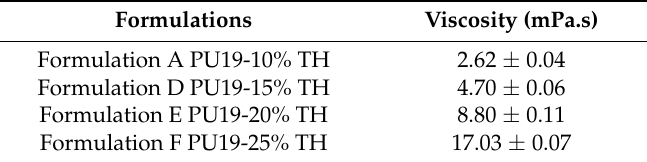
Table 3. Viscosity values of therapeutic nail lacquers (mean ± SD, n =